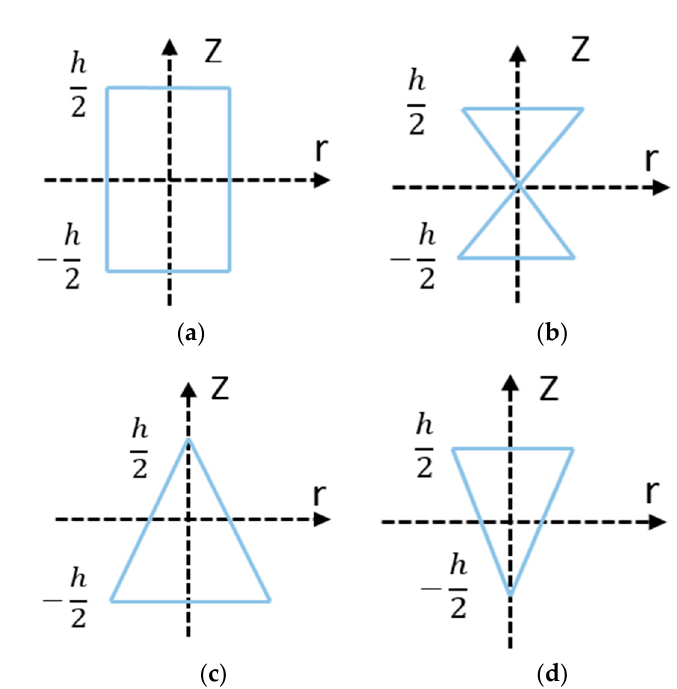
Figure 3. Distribution patterns of carbon nanotube (CNT) through the thickness of the multiscale hybrid annular plate. ( a ) UD; ( b ) FG-X; ( c ) FG-A; ( d ) FG-V. Properties of functionally graded (FG) and uniform distribution of NCM along the thickness direction of the annular plate are displayed in Figure 4 and expressed according to the following